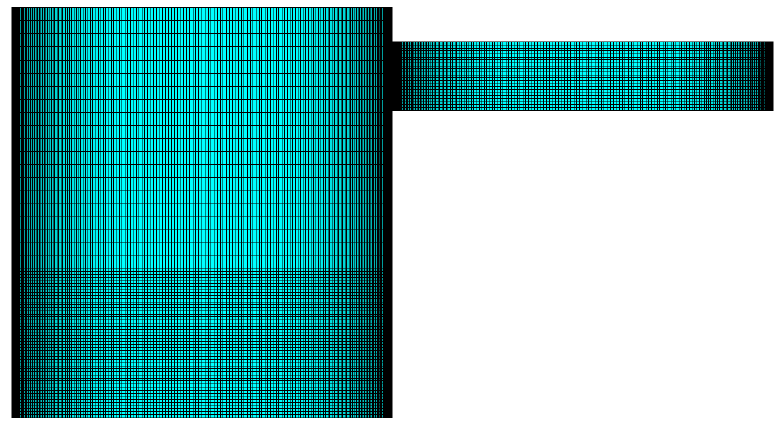
Figure 1. The finite element model of spinning closure.